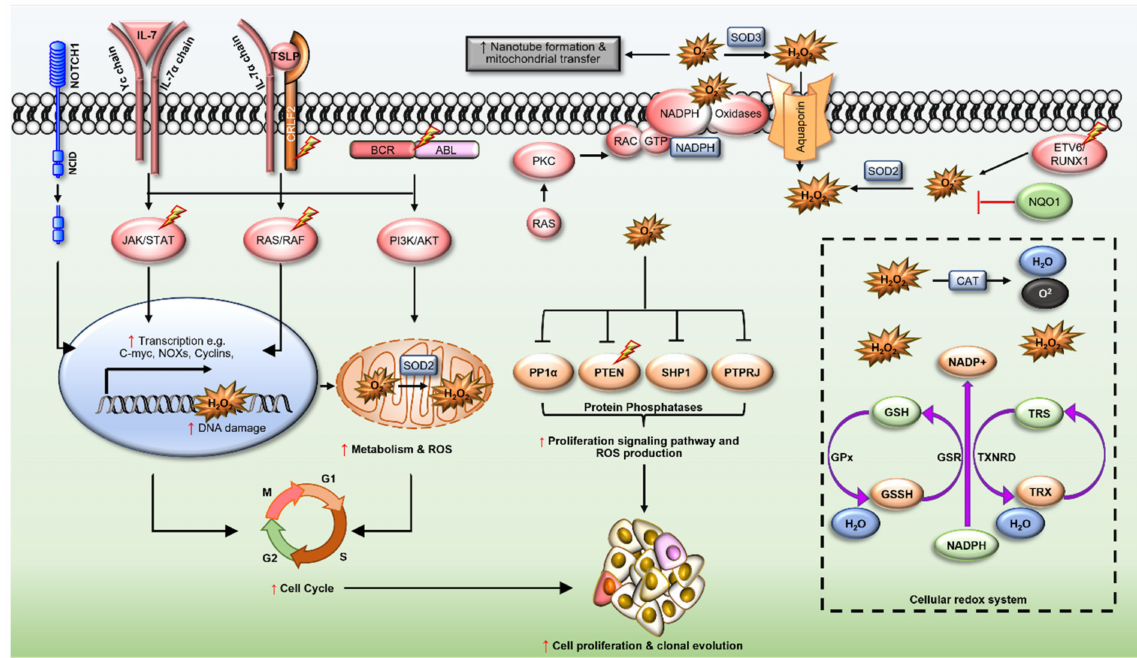
Figure 1. Signalling pathways linked to reactive oxygen species production in acute lymphoblastic leukaemia. Recur- ring somatic mutations to CRLF2 , JAK , NQO1 , NOTCH1 and RAS , chromosomal translocations such as BCR/ABL and ETV6/RUNX1 as well as overexpression of CRLF2 and IL7 receptor drive excessive production of intracellular reactive oxygen species (ROS) production (superoxide- O 2. − and hydrogen peroxide- H 2 O 2 ) in acute lymphoblastic leukaemia (ALL). High-level ROS production drives redox signalling through oxidative posttranslational modifications that increase the activity of kinases and inactivate protein tyrosine phosphatases, and cause lipid peroxidation and genomic instability leading to leukaemia progression and chemotherapy resistance. Cellular redox systems (shown in the hashed rectangle) regulate ROS homeostasis by converting H 2 O 2 to water and suppress ROS induced apoptosis. Red shapes = proteins with increased activity or expression; dark green = proteins with decrease activity or expression; orange = oxidised proteins; light green = reduced